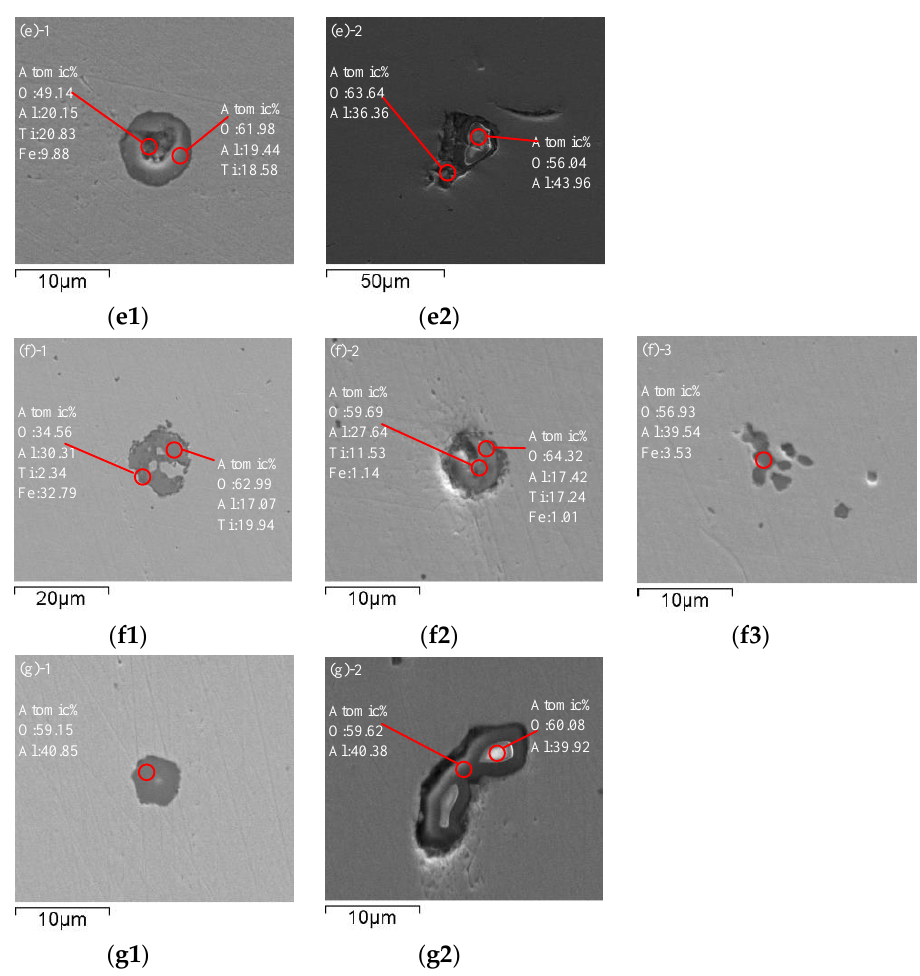
Figure 2. Typical inclusions in molten steel: ( a ) Before tapping; ( b ) Before vacuum start; ( c ) After decarburization; ( d ) After adding aluminum for 2 min; ( e ) After adding titanium for 2 min; ( f ) After RH treatment; ( g ) From tundish.